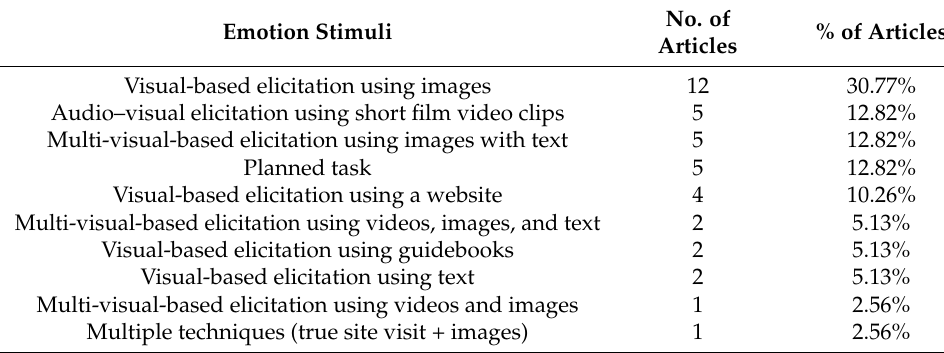
Table 3. Emotion stimuli in neuro-tourism. No. of % of Articles Emotion Stimuli Articles Visual-based elicitation using images 12 30.77% Audio–visual elicitation using short film video clips 5 12.82% Multi-visual-based elicitation using images with text 5 12.82% Planned task 5 12.82% Visual-based elicitation using a website 4 10.26% Multi-visual-based elicitation using videos, images, and text 2 5.13% Visual-based elicitation using guidebooks 2 5.13% Visual-based elicitation using text 2 5.13% Multi-visual-based elicitation using videos and images 1 2.56% Multiple techniques (true site visit + images) 1